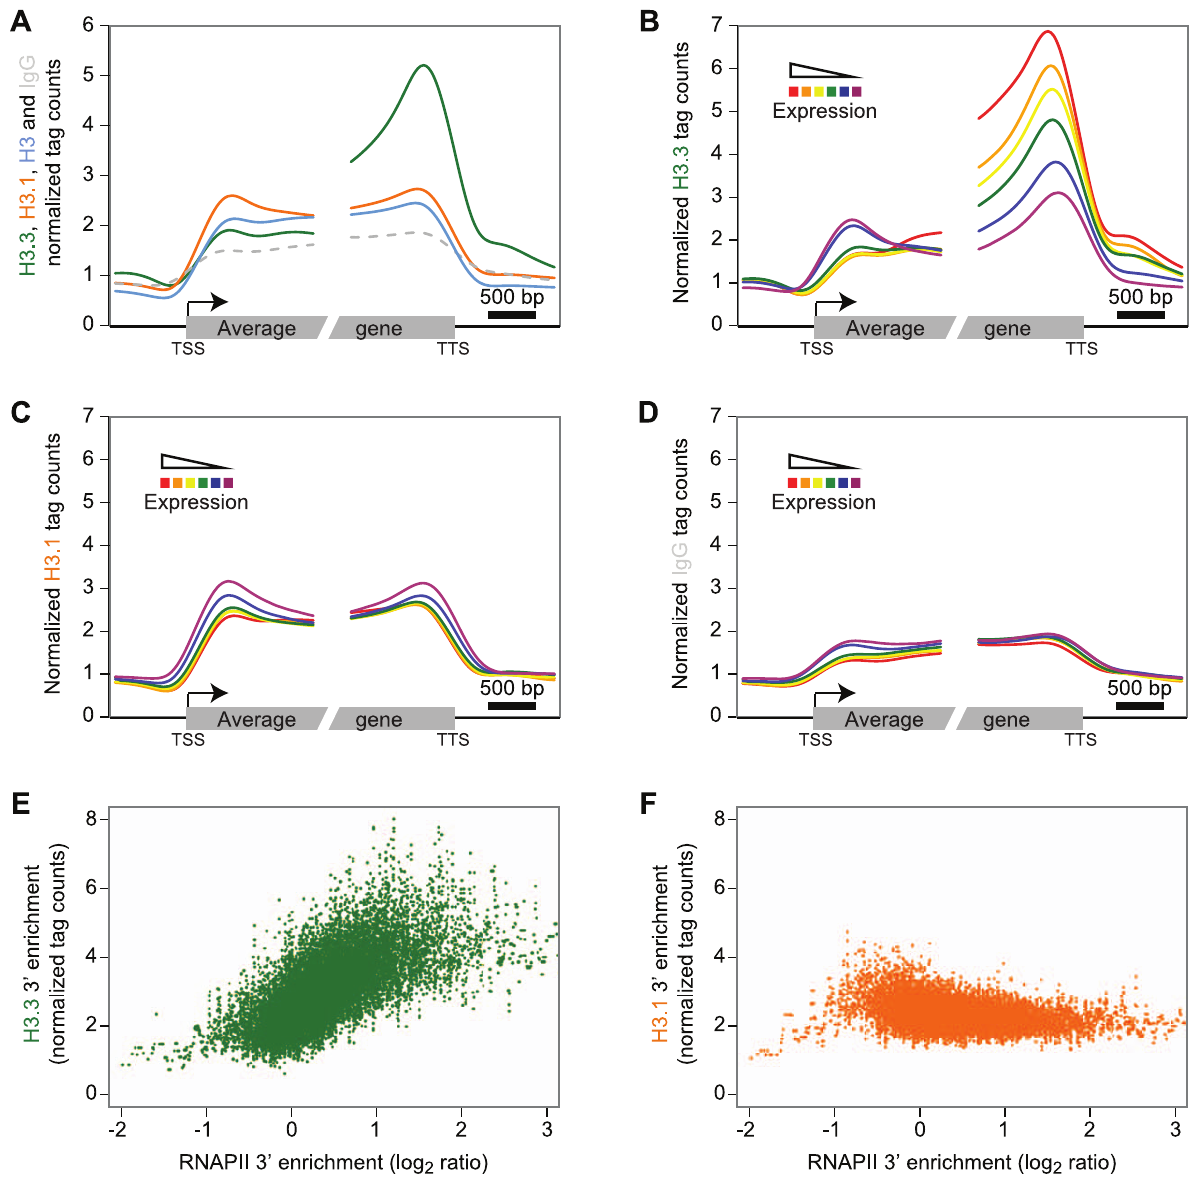
Figure 2. H3.3 enrichment profile over genes correlates with expression and is biased towards the 3 9 end. (A) Average profile of H3.3 (green), H3.1 (orange), H3 (blue) and IgG (dashed grey) over gene bodies (all 14048 expressed protein-coding genes). Only the H3.3 profile peaks towards the 3 9 end of the transcribed sequences. (B–D) Average profile of H3.3 (B), H3.1 (C) and IgG (D) enrichment over the protein-coding genes grouped according to their expression levels into six different subsets (from the red to the purple curves corresponding to FPKM . 30, 20–30, 10–20, 5–10, 1–5, 0–1, and containing 3179, 1463, 2897, 2344, 2780 and 1263 genes, respectively). Note the strong correlation between levels of expression and H3.3 enrichment (B). By contrast, H3.1 enrichment does not appear to be linked with transcription (C). (E–F) Scatterplots of the H3.3 (E) and H3.1 (F) versus RNAPII 3 9 enrichment calculated on the last 1 kb of the genes. A sliding window of 10 genes was applied on both H3 variants and RNAPII enrichment. Only H3.3 is showing a positive correlation with